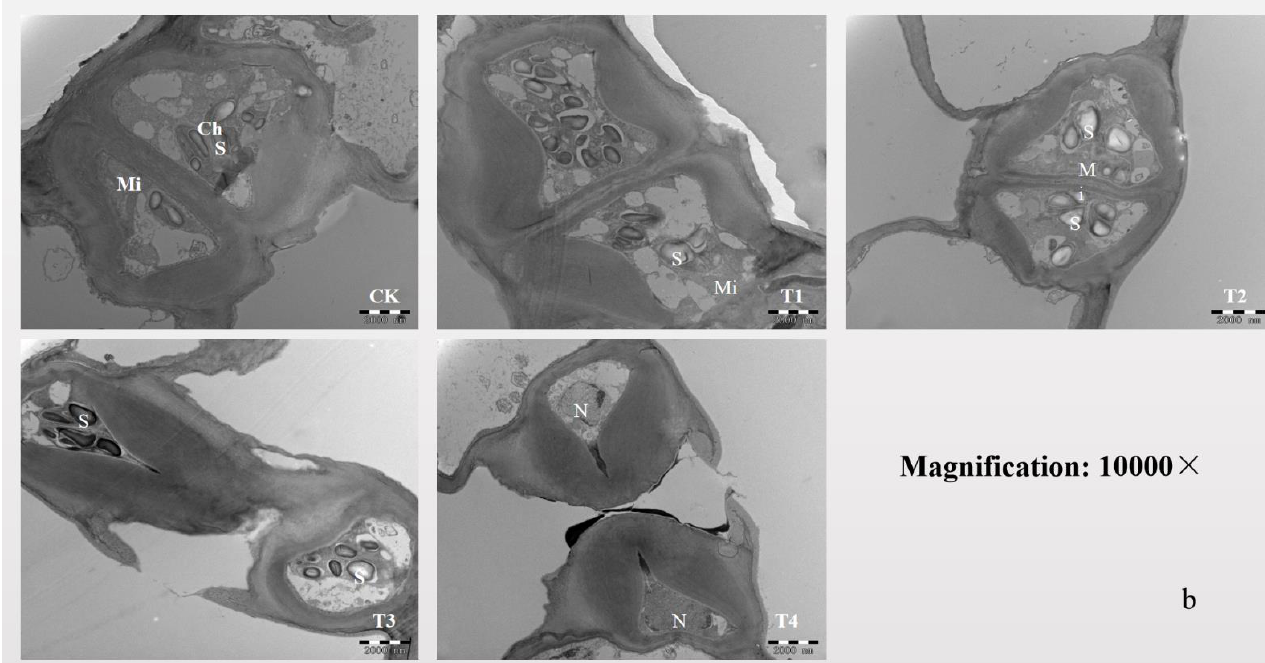
Figure 5. ( a , b ): Effects of water stress on chloroplast and stomatal ultrastructures of Glycyrrhiza ura- lensis . Ch, Mi, G, S, OG, P, CW, and N represent the chloroplast, mitochondrion, granalamellae, starch grain, osmiophilic granule, plastoglobulis, cell wall, and nucleus, respectively.